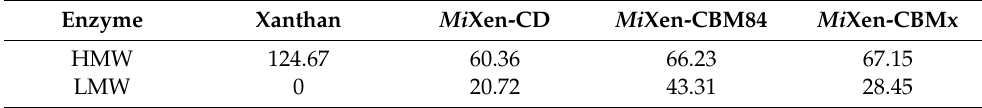
Table 4. Quantitation of peak areas in gel permeation chromatography.